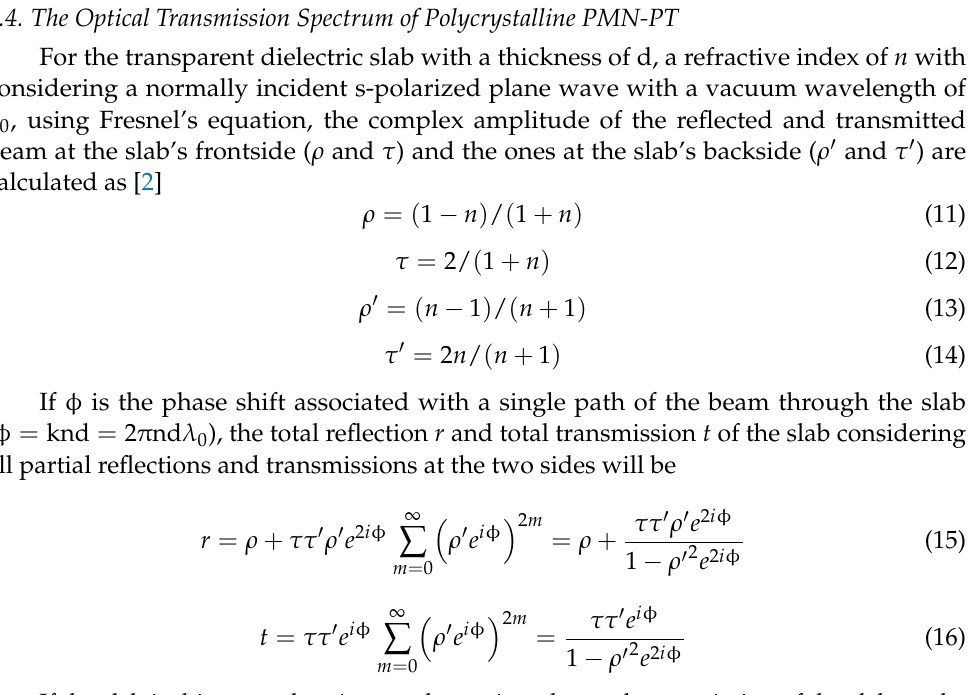
Figure 6. The measured fringe position was used to extrapolate the zeroth-order fringes (at 0 cm − 1 ) to assign absolute fringe order numbers to each fringe position.